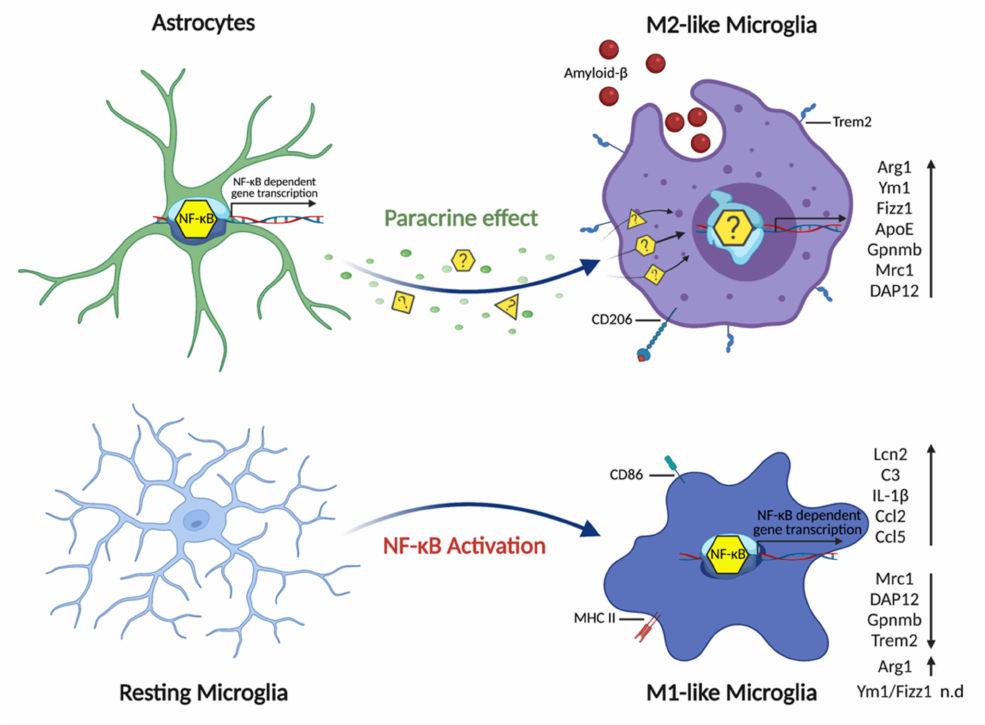
Figure 9. Activation of IKK2/NF- κ B signaling in astrocytes promotes M2-like microglia polarization. IKK2/NF- κ B activation restricted to astrocytes induces a genetic program that may promote the release of paracrine acting factors or create a condition, which enhances microglial differentiation toward a phagocytic phenotype as indicated by upregulation of typical M2-like marker gene ex- pression. As an outcome, β -amyloid plaque deposition is significantly reduced in the context of the APP23 mouse model of AD. On the cellular level, microglial cells change their morphology from a resting ramified status to a globose-amoeboid one, reflecting the shape known to be competent to phagocyte amyloid deposits within the brain. On the contrary, cell-intrinsic NF- κ B activation in primary microglial cells induces a pro-inflammatory phenotype with massive upregulation of inflammatory factors together with the downregulation of specific phagocytic markers as